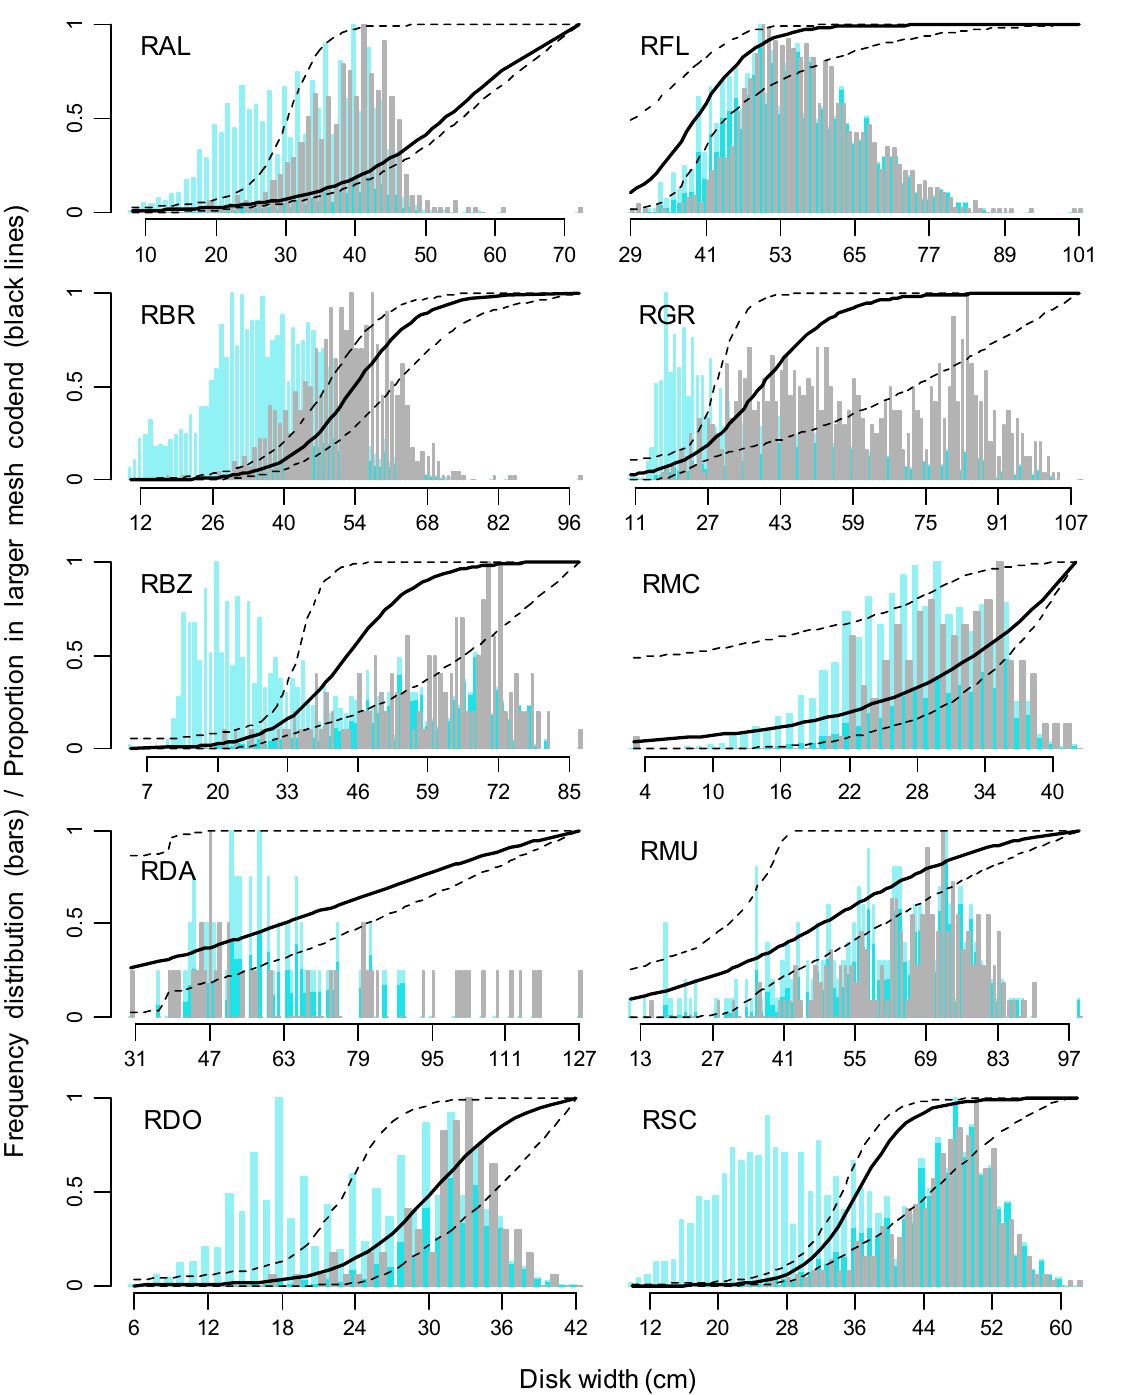
Disk width (cm) Figure 2. Combined disk width frequency distributions in 90 mm mesh (blue) and 400 mm mesh (grey) per skate species. Lighter sections of the blue bars: fractions per disk width interval deselected to equalize 90 mm mesh catches to 400 mm mesh catches. Black lines: SELECT logistic models of proportions retained in the larger mesh ± 95% confidence intervals. Species codes correspond to Table 2.